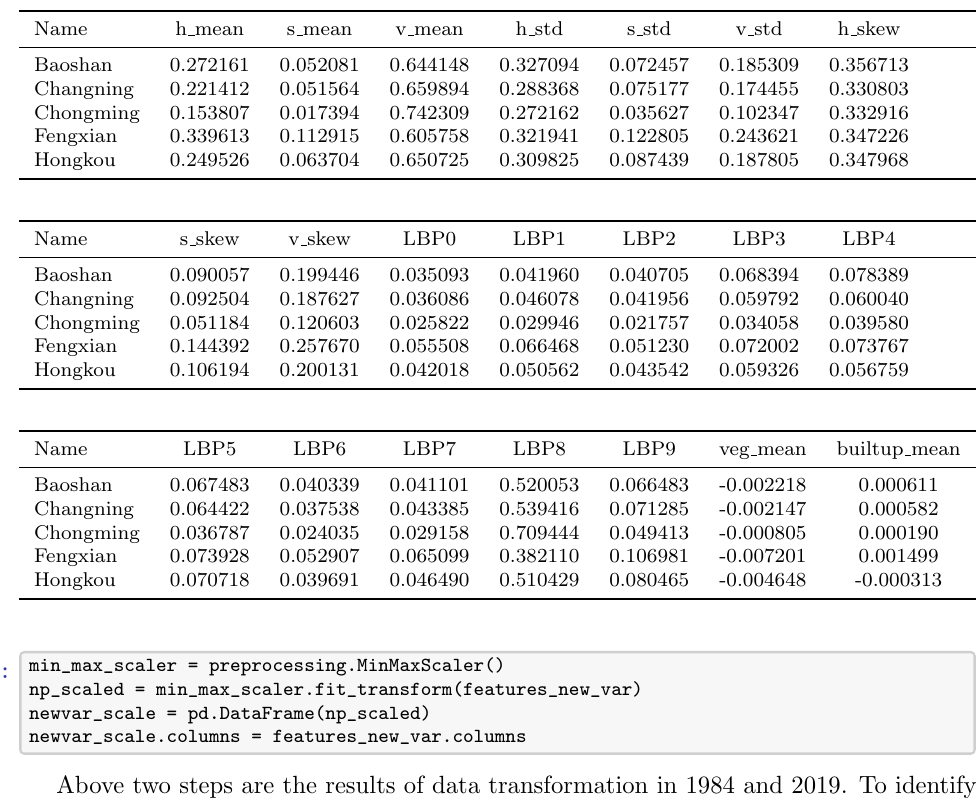
Table 11: Four types of features (21 in total) identified in 1984